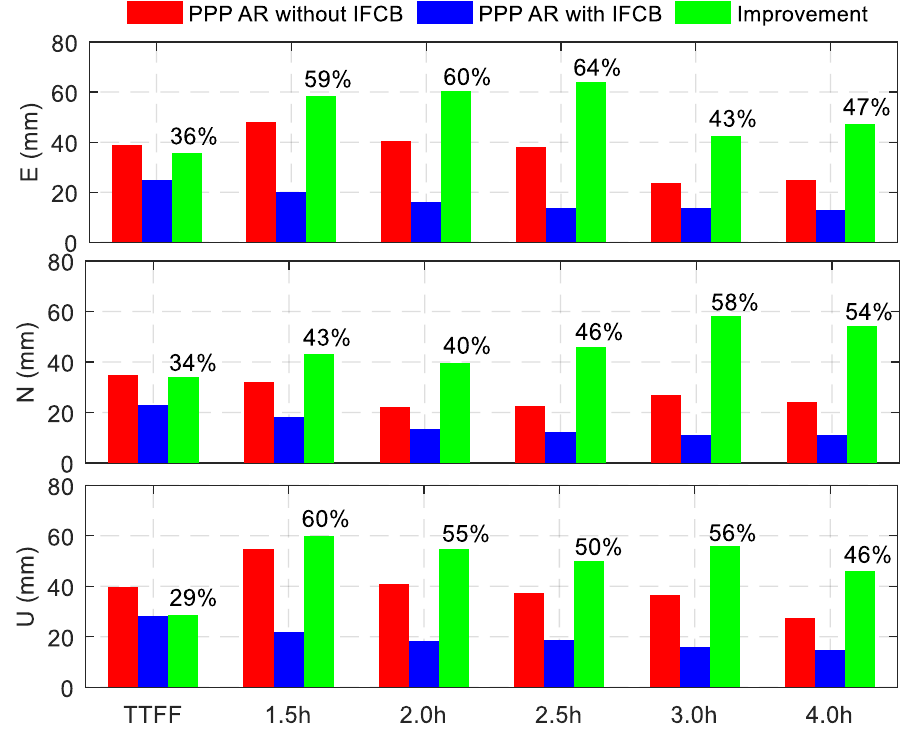
Figure 8. Root mean square ( RMS) of positioning errors at different sessions in the east, north and up components for UDUC-PPP AR with or without IFCB